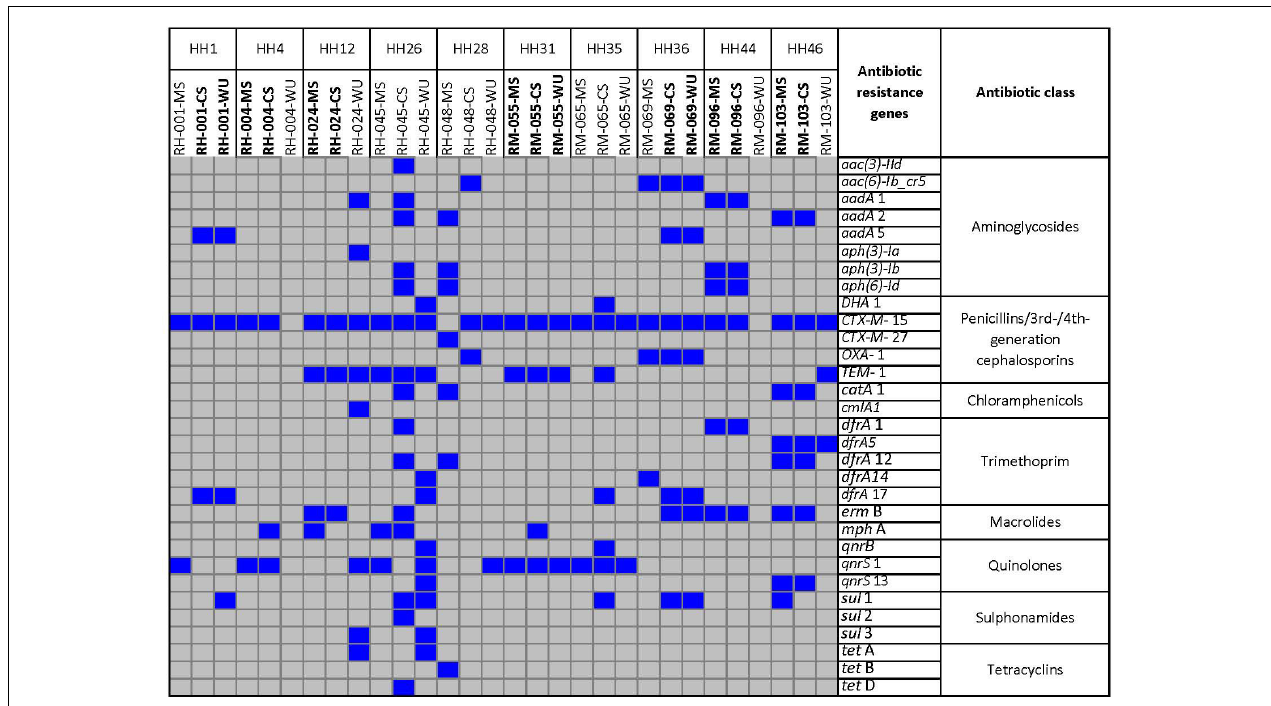
FIGURE 3 | Distribution of antibiotic resistance genes retrieved from whole-genome sequence of 30 E. coli strains isolated from CS, MS, and WU samples from 10 households. Blue and gray boxes indicate presence and absence of genes, respectively. HH, households; MS, mother stool; CS, child stool; WU, point-of-use drinking